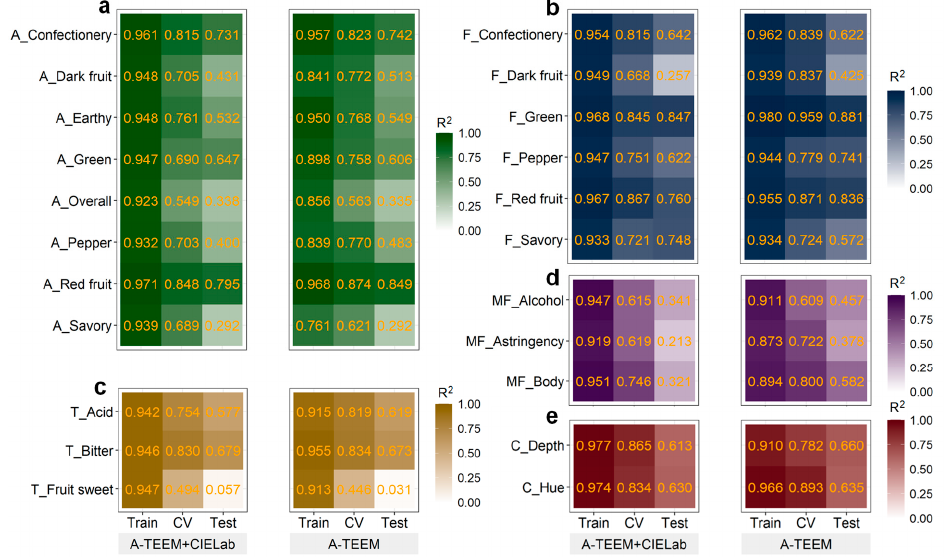
Figure 3. Summary of coefficient of determination (R 2 ) values for XGBoost Train (calibration), cross- validation (CV), and Test (externally validated) models using feature-level (A-TEEM and CIELAB datasets) or variable-level (A-TEEM only) data fusion methods from the analysis of grape extracts for the prediction of wine attribute scores associated with ( a ) aroma, ( b ) flavour, ( c ) taste, ( d ) mouthfeel, and ( e ) colour.